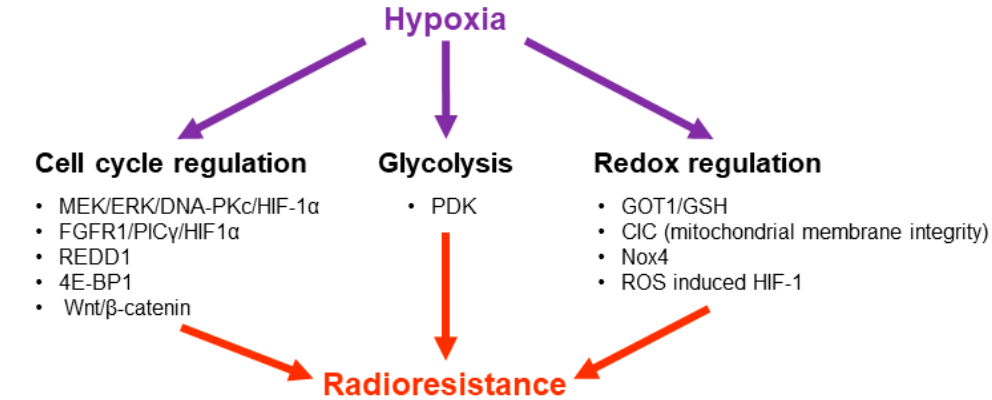
Figure 5. The role of hypoxia in GB radioresistance. Cell cycle regulation, glycolysis and Redox/ROS regulatory mechanisms have been shown to support hypoxia dependent radioresistance in GB cells.